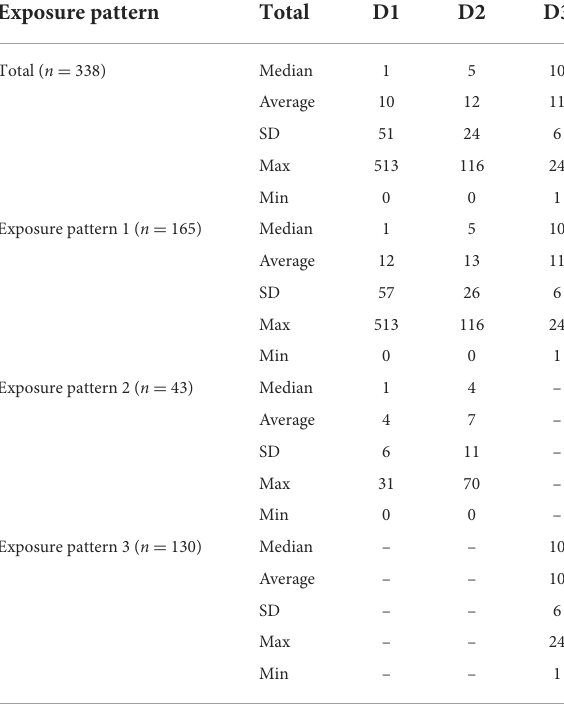
TABLE 4 Summary of short-term exposures (E1-E3) among library workers. Exposure pattern Total E1 E2 E3 Relative value to ICNIRP RL (%) for E1 and BR (%) for E2 and E3 Total ( n 338) =